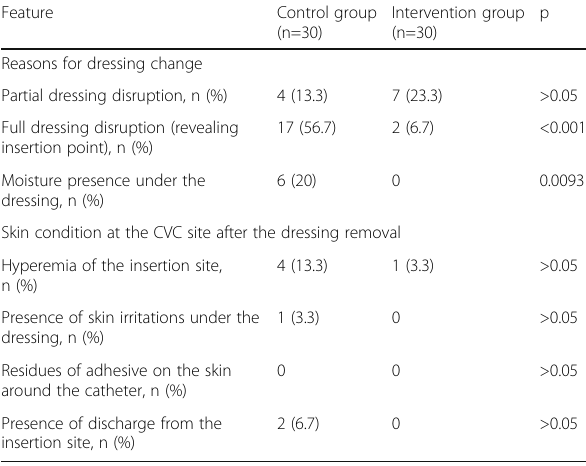
Table 22 (abstract A37). Reasons for dressing change and skin condition at